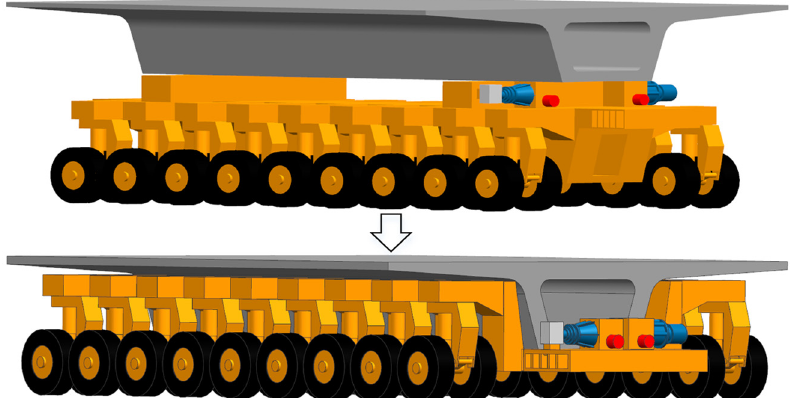
Figure 29. Height improvement programme for beam truck.